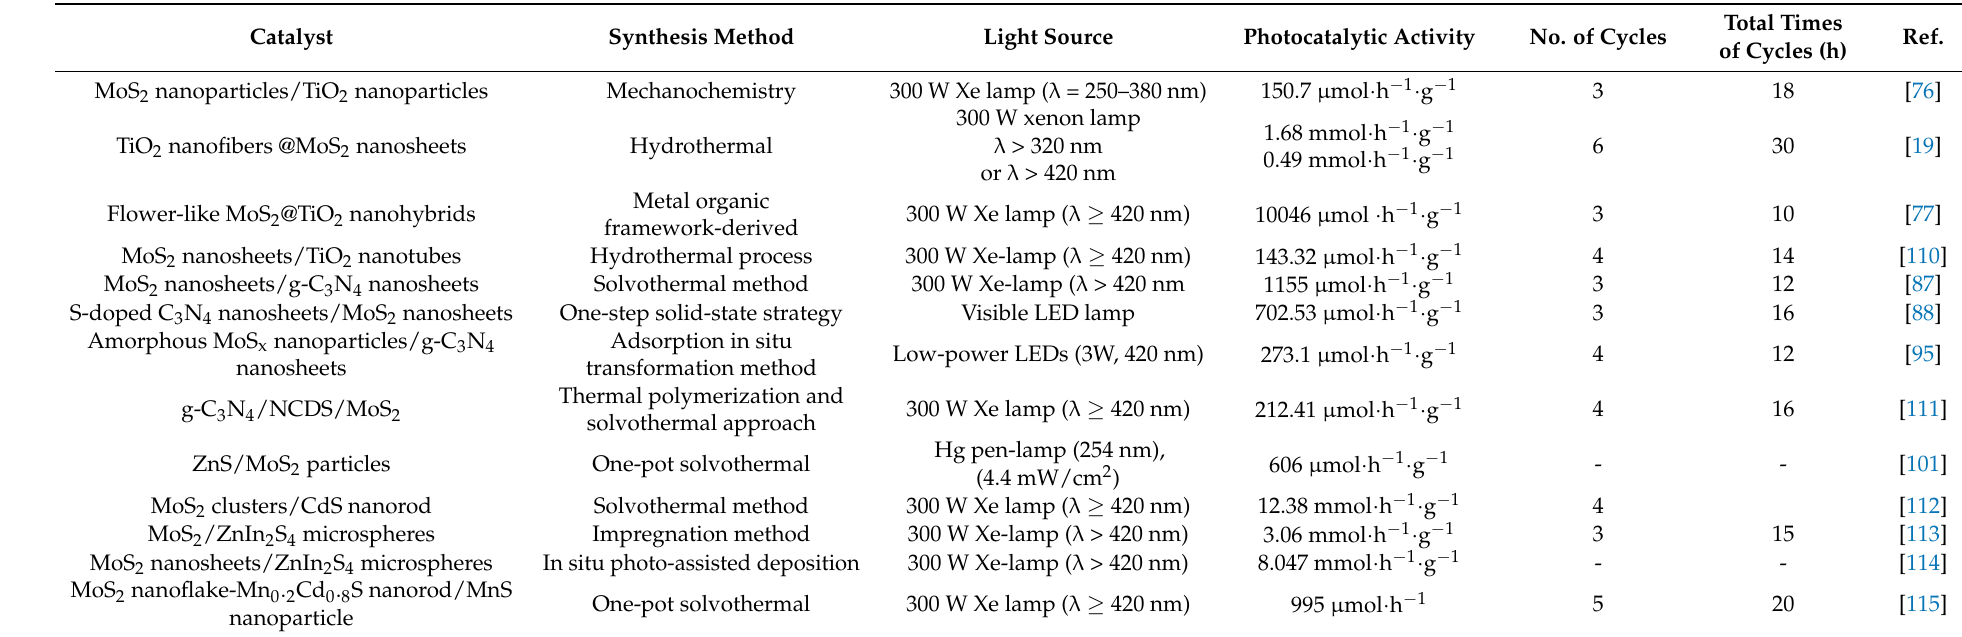
Table 1. Summary of MoS 2 usage as a co-catalyst for various materials to form heterostructures for photocatalytic hydrogen